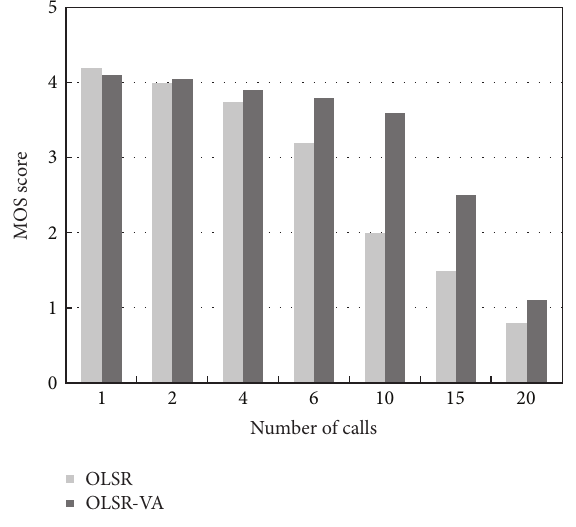
Figure 8: MOS versus number of